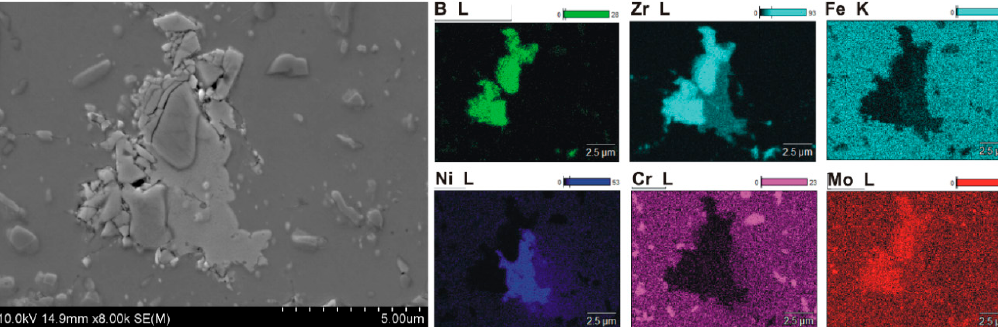
Figure 7. Microstructure and element surface distribution (WDS) of steel + 20% ZrB 2 composites.